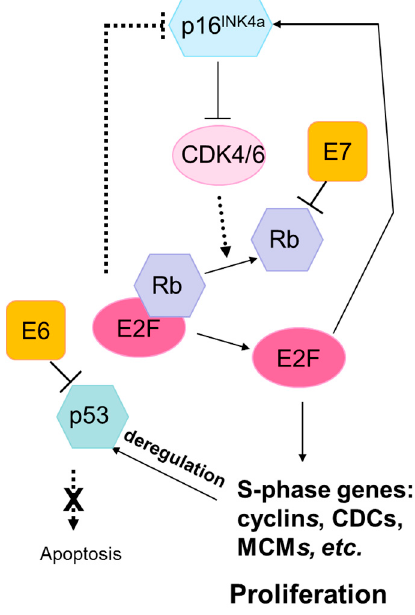
Figure 1. The Rb and p53 pathways are disrupted by the human papilloma virus (HPV) oncoproteins E7 and E6, respectively. The HPV E7 protein binds to Rb with high affinity, disrupting its interaction with the transcription factor E2F. This results in the release and activation of E2F, driving expression of S-phase genes and cell cycle progression. P16 INK4A is a cyclin-dependent kinase inhibitor that regulates the cell cycle by inactivating cyclin-dependent kinases involved in Rb phosphorylation. Upregulation of p16 INK4A is induced by HPV-mediated disruption of E7, leading to the accumulation of p16 INK4A in HPV-transformed cells. The HPV E6 protein inhibits apoptosis by targeting the tumor suppressor protein, p53, for degradation. HPV E6 inhibition of p53 promotes cell proliferation and can lead to genomic instability and the accumulation of somatic mutations. Abbreviations: Rb, retinoblastoma protein; p16 INK4A , cyclin-dependent kinase inhibitor 2A; CDK, cyclin-dependent kinases; E2F, E2F transcription factor; CDC, cell-division-cycle genes; MCM, minichromosome maintenance family.